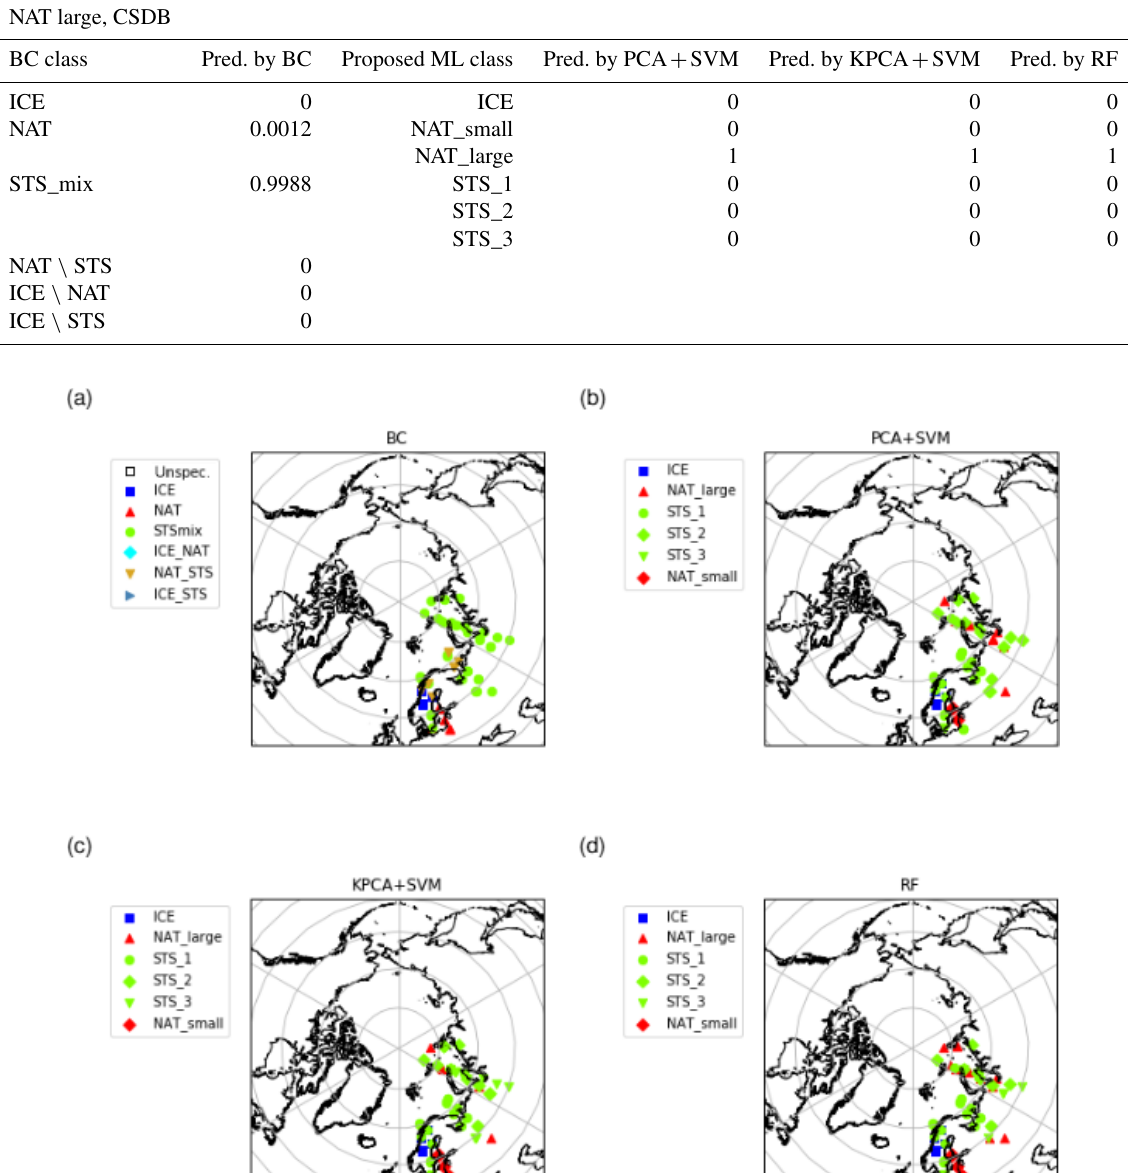
Table 7. Predicted labels vs. CSDB classes, with analysis restricted to NAT large (radius > 2µm).